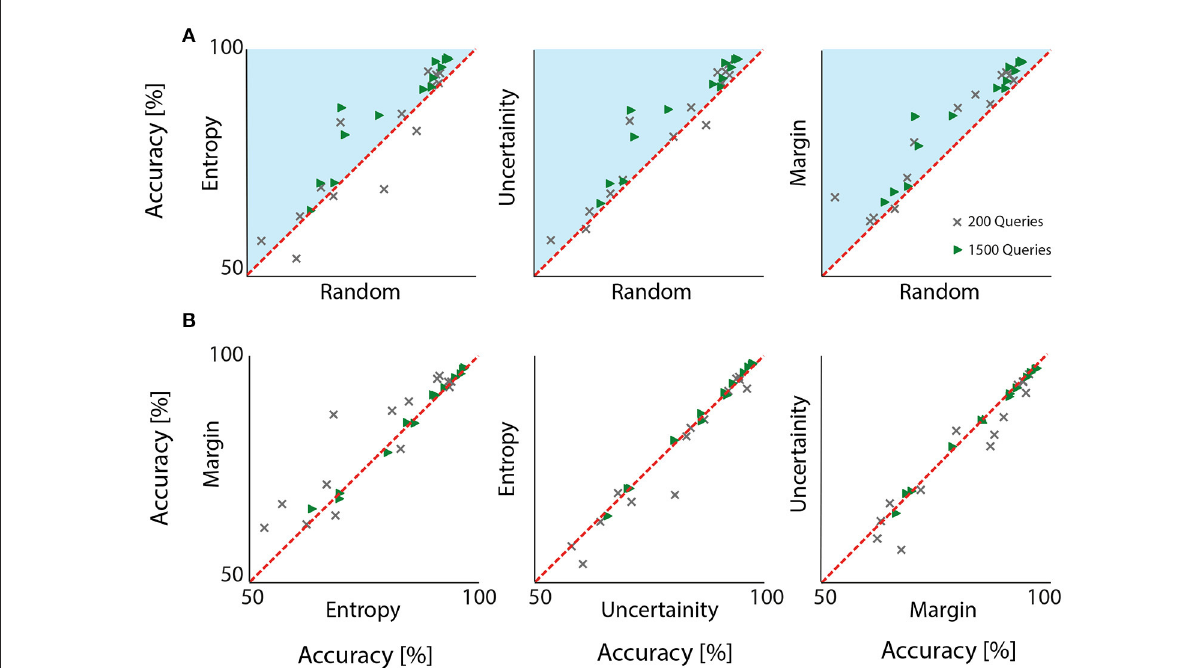
FIGURE3 Accuracy plots to compare all investigated query strategies at two stages: After the first 200 and after all 1,500 queried samples. Each marker represents results from one participant. Random sampling (in A ) compared against the remaining three approaches shows a visible tendency to achieve lower accuracy. Irrespective of the choice of query sampling, active learning outperformed the conventional random sampling, because results from all participants lie above the unity line, i.e., in the blue zone, when 1,500 samples were selected. A similar conclusion can be drawn when 200 samples wee drawn although for a very few participants, random sampling was more successful. When different active learning query strategies were compared (B) , different query sampling were comparable but margin sampling seemed to offer a lightly higher